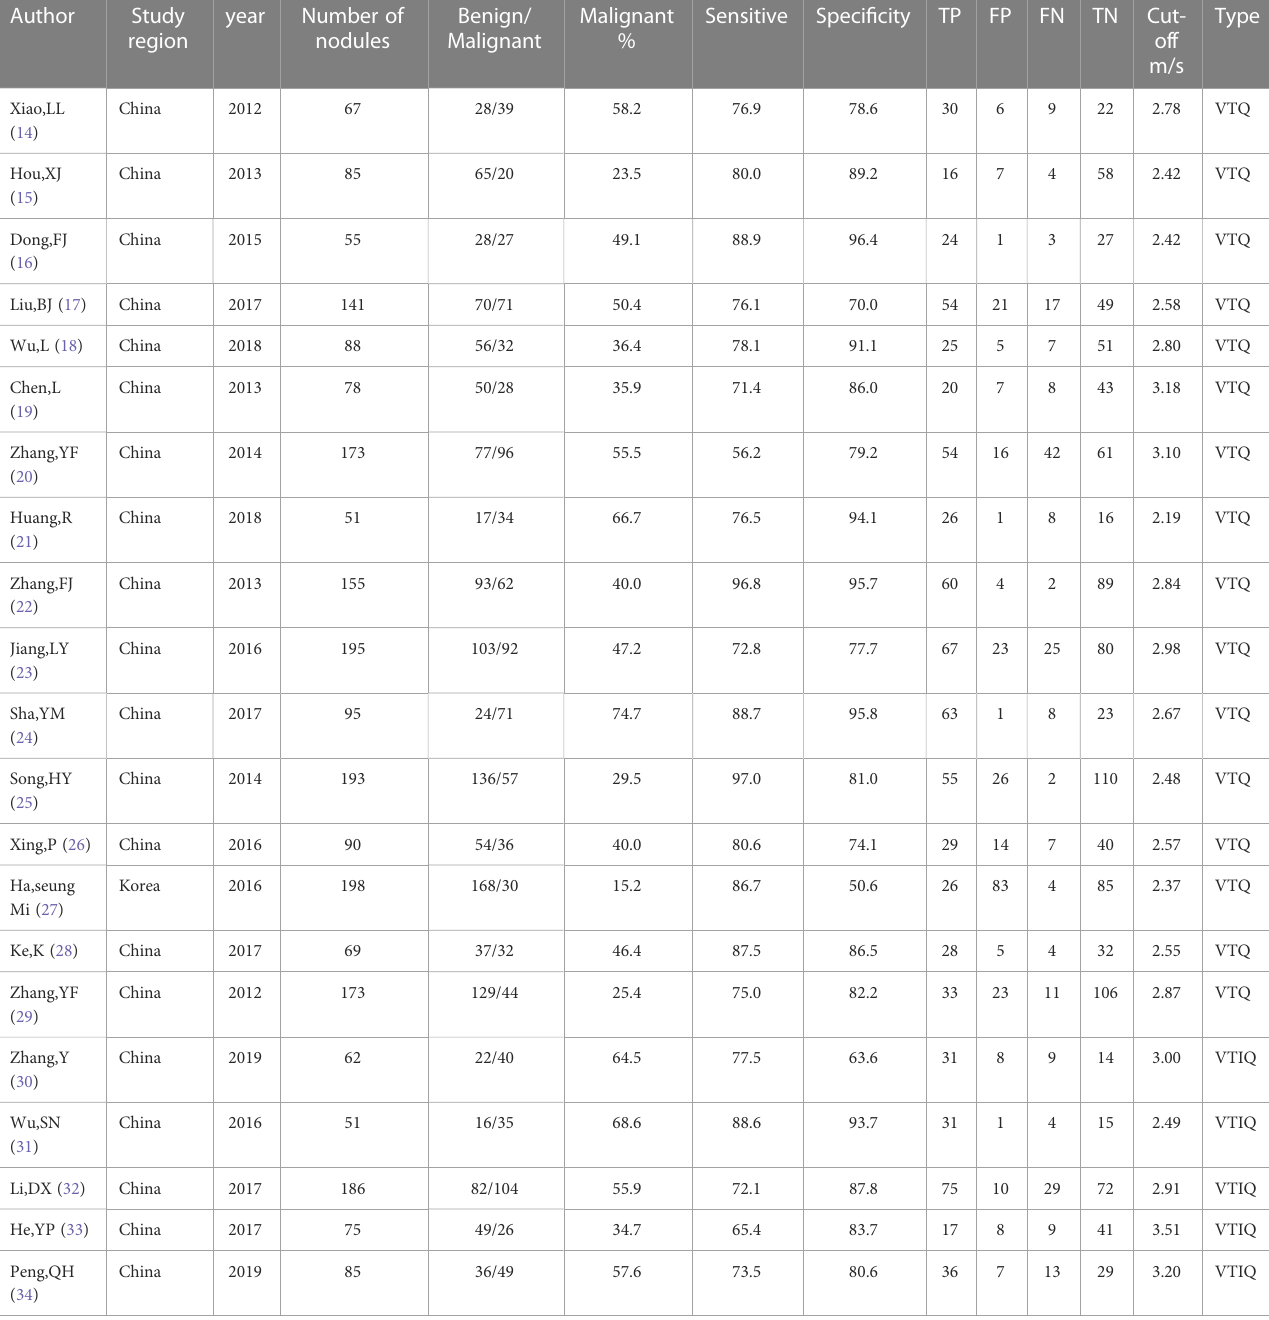
TABLE 1 Characteristics of Group A